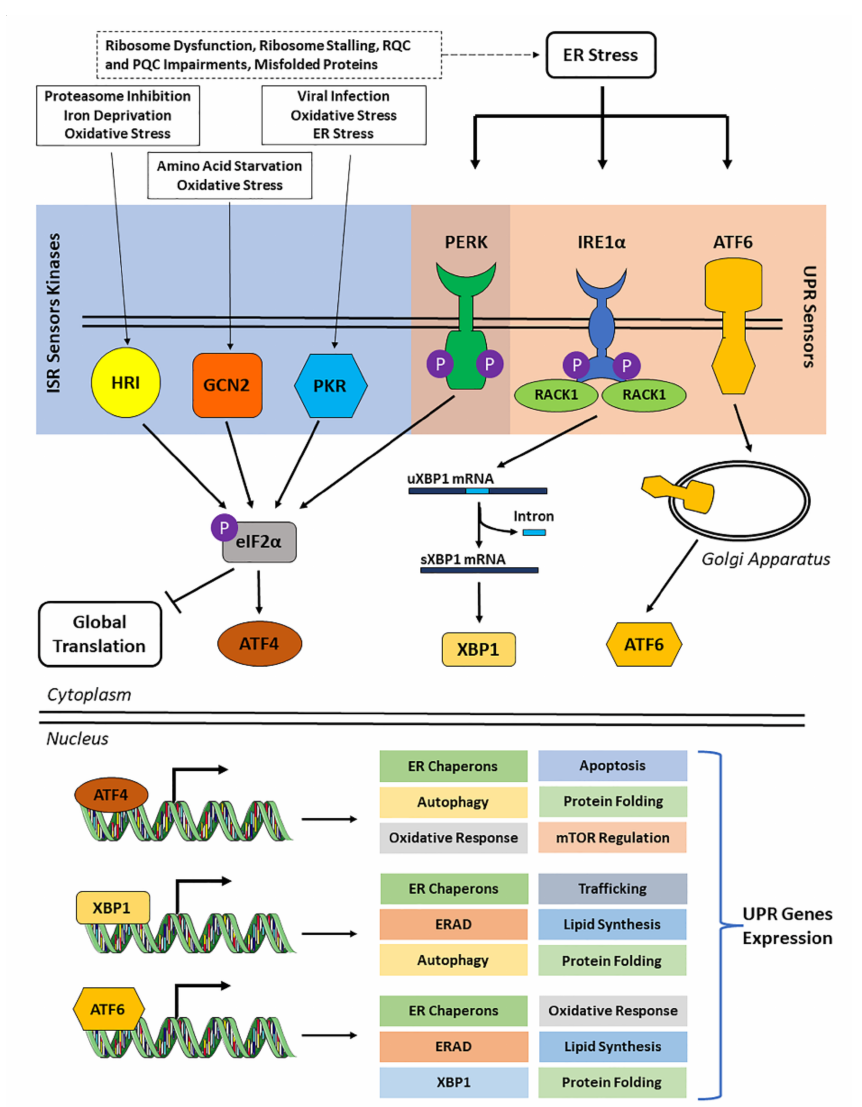
Figure 3. The unfolded protein response (UPR) and the integrated stress response (ISR). The accu- mulation of misfolded proteins in the ER leads to ER stress, which triggers intracellular stress sensors (UPR and/or ISR sensors) that can activate stress response pathways to maintain ER homeostasis. However, an excessive unresolved or chronic ER stress can trigger apoptosis responses leading to a different cell fate. The UPR sensors (PERK, IRE1 α and ATF6) reside in the ER membrane, while ISR sensors (i.e., PKR, GCN2 and HRI) are cytoplasmic kinases that respond to different stressors than those of the UPR. The UPR and ISR pathways converge at the PERK sensor which, after its dimeriza- tion, halts global translation by phosphorylating eIF2 α on Ser51. The IRE1 α features a cytoplasmic kinase domain and RNase domain; upon dimerization and auto-phosphorylation, IRE1 α induces its kinase and endoribonuclease activities, leading to unconventional splicing of X-box-binding protein-1 (XBP1) mRNA [55]. In this regard, RACK1 (receptor for activated C kinase 1) has been reported to activate IRE1 α -XBP1 signaling pathway and induce neuroprotection in rat models [56], and the IRE1 α -RACK1 axis has been shown to orchestrate cytoprotective responses after ER stress [57]. The ATF6 has a cytoplasmic domain which, upon ER stress, is processed in the Golgi apparatus, and an ATF6 fragment is released in the cytoplasm. After its activation, the UPR pathway induces central transcription factors ATF6, XBP1, and ATF4 that are redirected to the nucleus to mediate the expression of UPR downstream targets